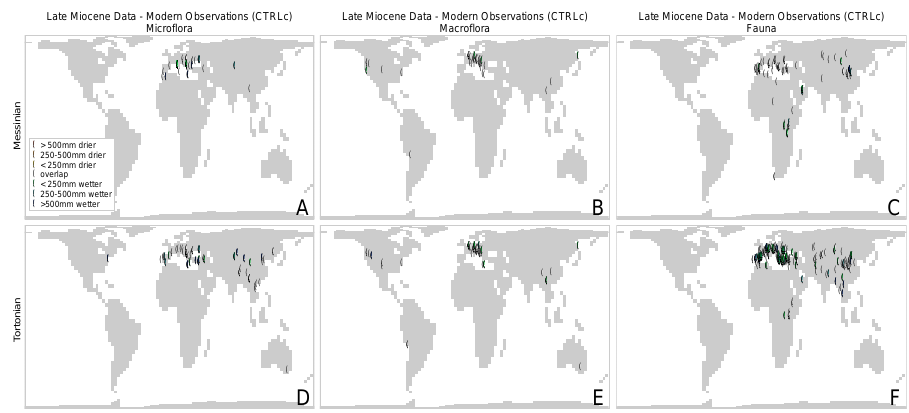
Fig. 11. Results from the model–data comparison for mean annual precipitation, late Miocene data–modern potential natural climate esti-